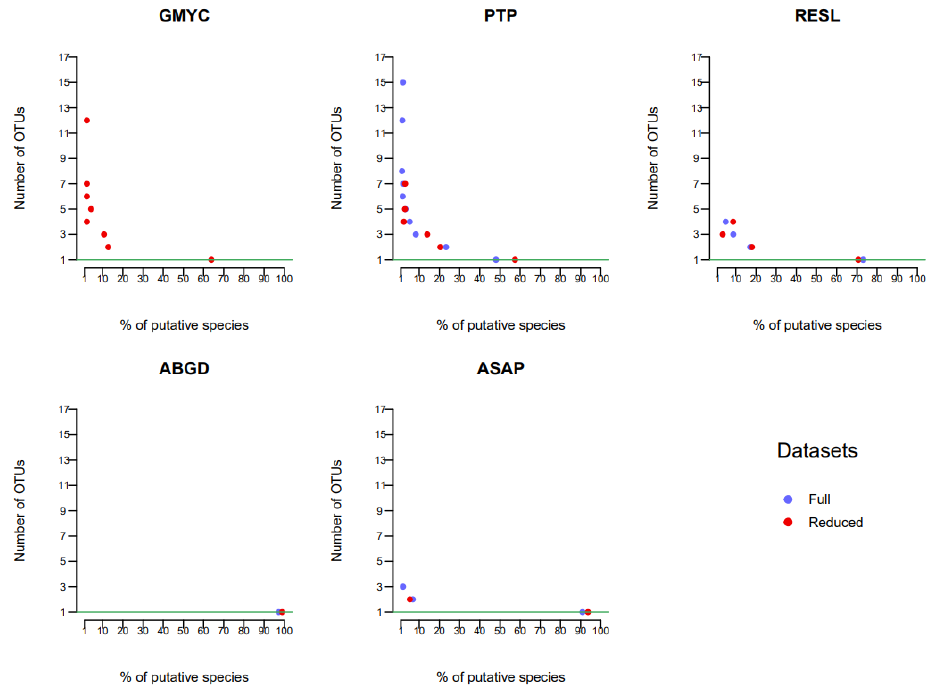
Figure 7. Mismatch rates corresponding to splits (when a putative species is split into several OTUs) obtained while processing dataset 1 with the five delimitation methods. The graphs represent, for the dataset in its full version or after reduced to one sequence per haplotype, the proportion of putative species that are split by the different methods as a function of the magnitude of the mismatch (the number of OTUs resulting from the split). The dots on the horizontal green line indicate the proportion of putative species that are recovered in the OTU partitions (perfect match).